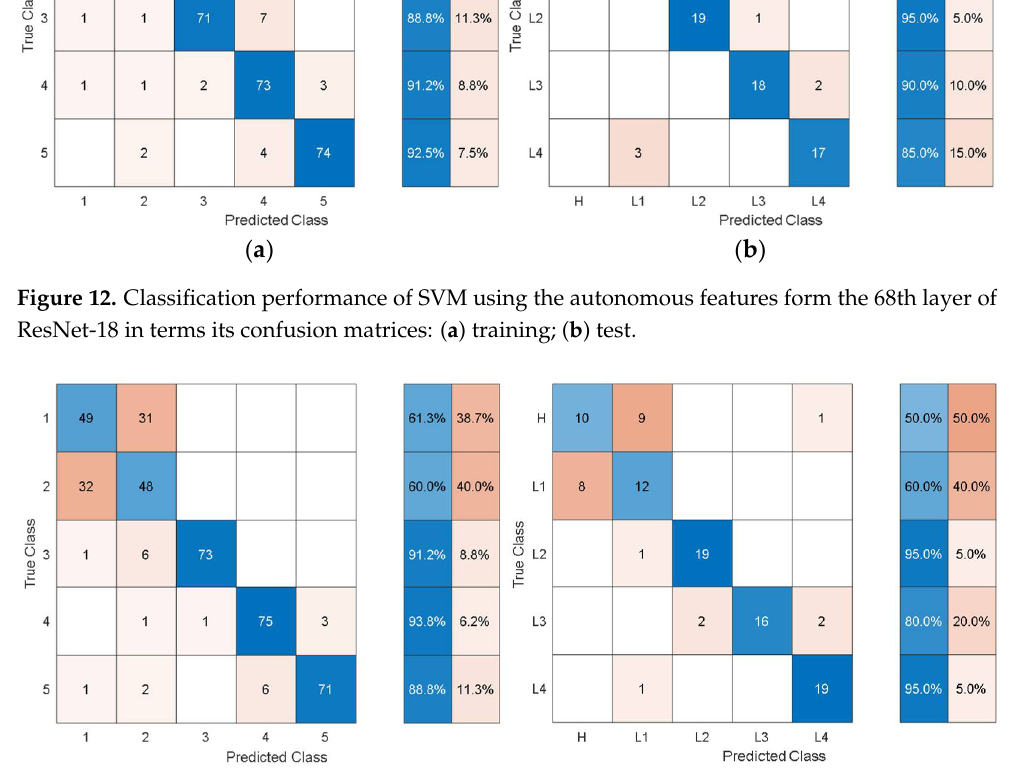
Figure 13. Classification performance of SVM using the autonomous features from the 39th layer of VGG-16 in terms of its confusion matrices: ( a ) training; ( b ) test.